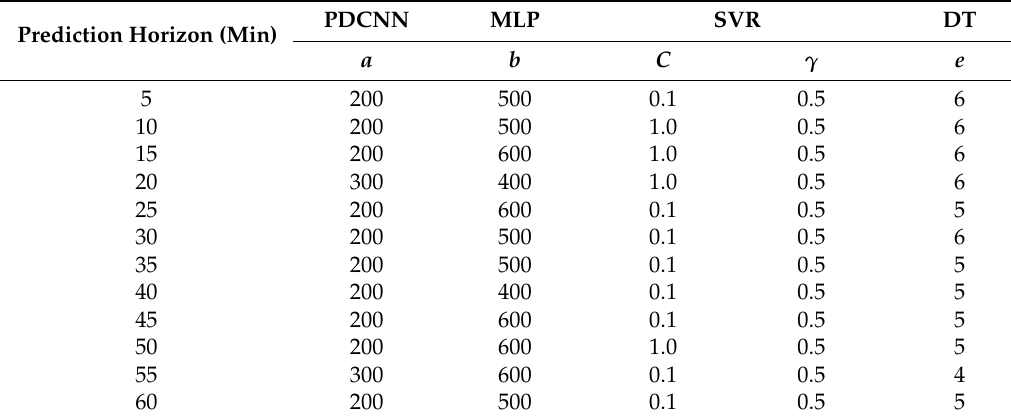
Table 1. Hyper-Parameters of Prediction Models.